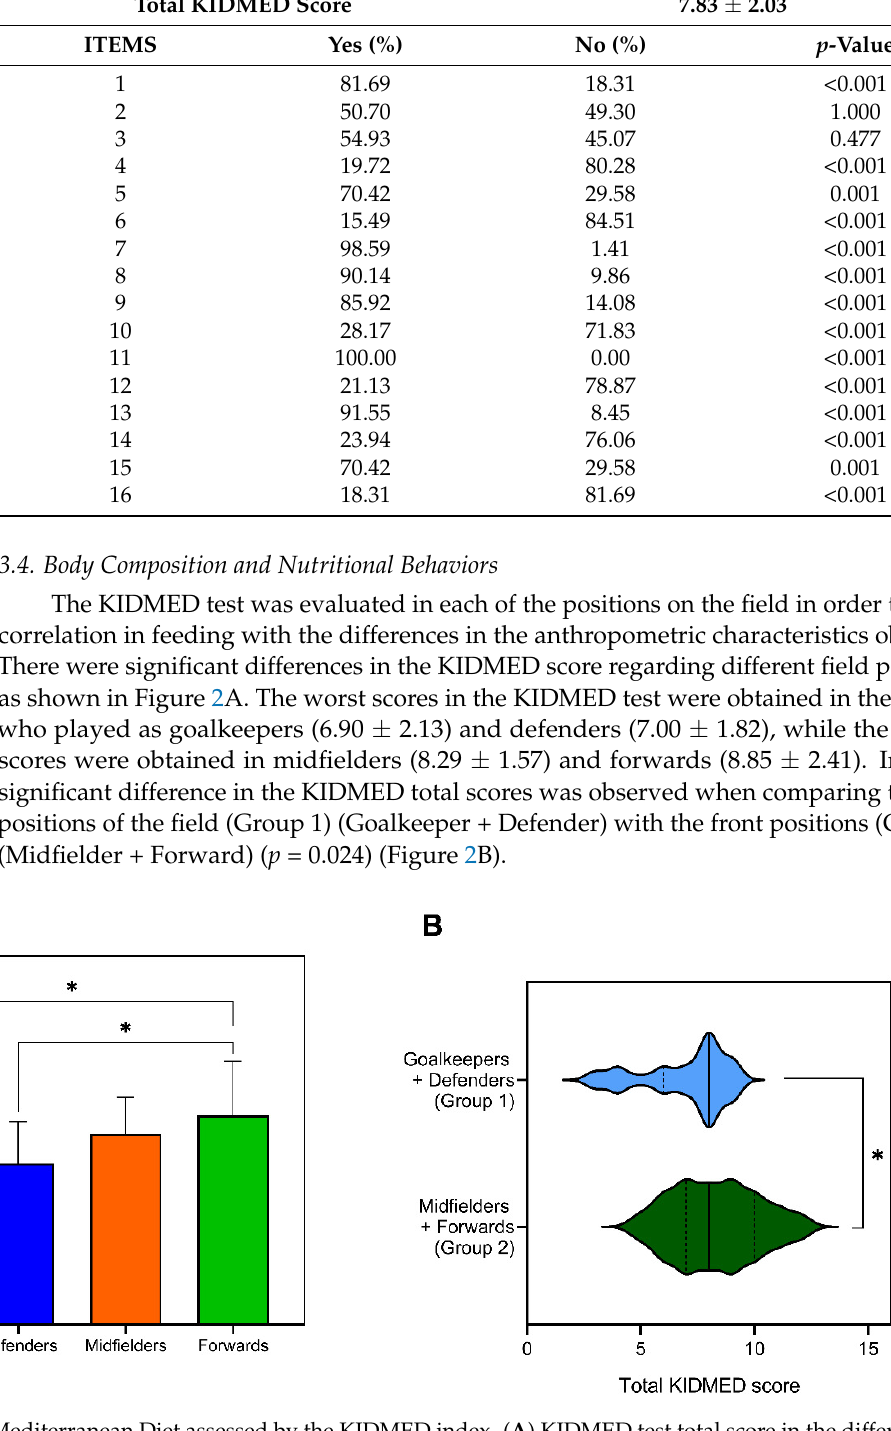
Figure 2. Adherence to the Mediterranean Diet assessed by the KIDMED index. ( A ) KIDMED test total score in the different playing positions; ( B ) KIDMED test total score when players are divided by field position in Group 1 (Goalkeepers and Defenders) and Group 2 (Midfielders and Forwards). *, p ≤ 0.05.